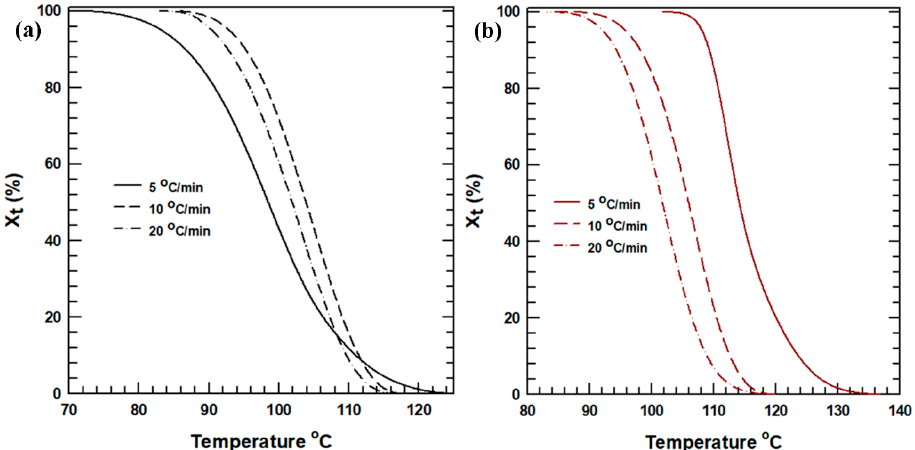
Figure 3. Relative crystallinity curve as a function of temperature: ( a ) neat PLA and ( b ) T-PLA50. The relative crystallinity curve of the neat PLA and T-PLA50 plotted as a function of the